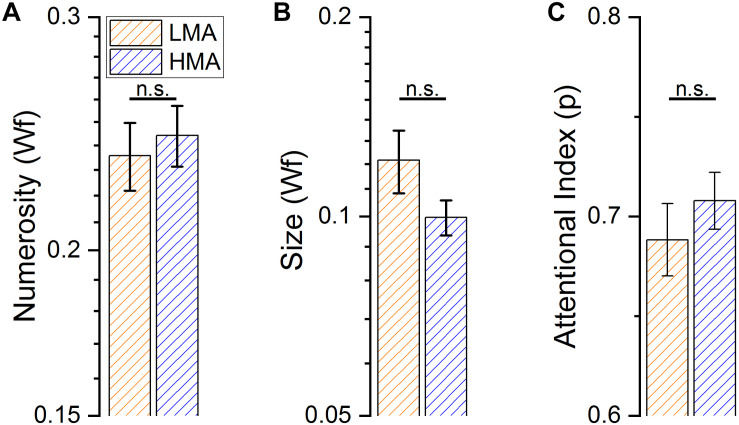
Performance in the three different psychophysical tasks. (A) Average numerosity discrimination thresholds (Weber fraction) for subjects with high (HMA) and low (LMA) levels of math anxiety. (B) Average object-size discrimination thresholds (Weber fraction) for subjects with high (HMA) and low (LMA) levels of math anxiety. (C) Average proportion of correct response in the Multiple Object Tracking task, for subjects with high (HMA) and low (LMA) levels of math anxiety.